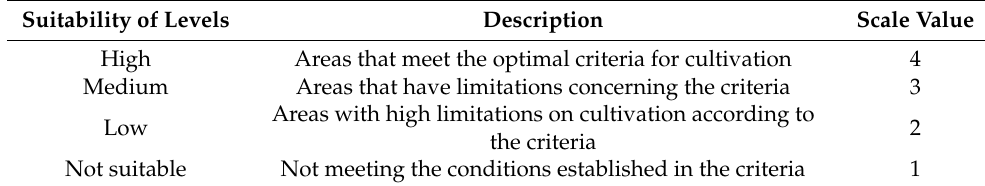
Table 1. Categorization of zones for Hass avocado cultivation.